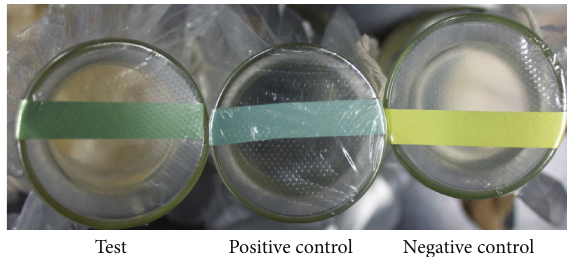
Figure 2: Determination of the presence of NH 4+ after addition of NaOH using paper pH indicator. Test: culture supernatant of strain B3 with substrate L-Leu; positive control: ammonia solution; negative control: culture supernatant of strain B3 without substrate